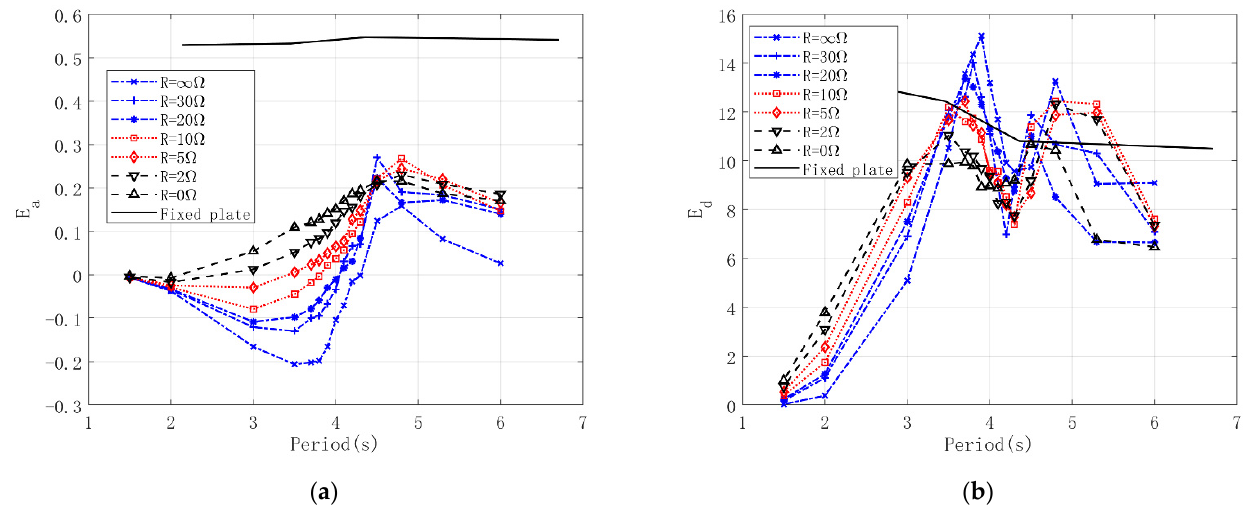
Figure 16. The equivalent hydrodynamic parameters of THP2 with different load resistance. ( a ) E a ;